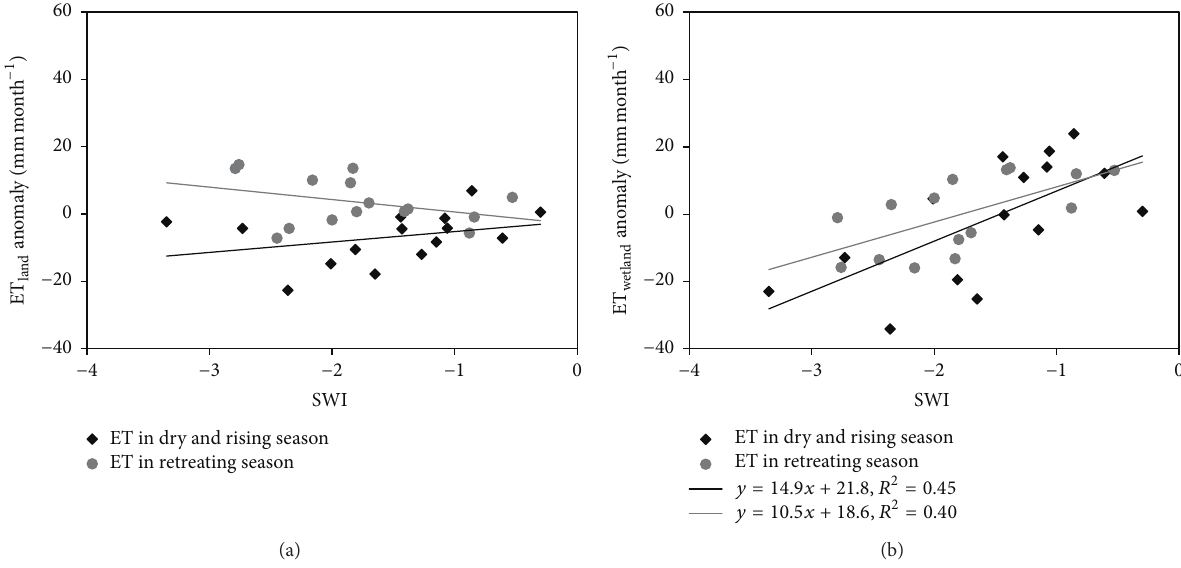
Figure 8: Response in (a) the land surface ET anomaly and (b) the wetland ET anomaly to the SWI during drought